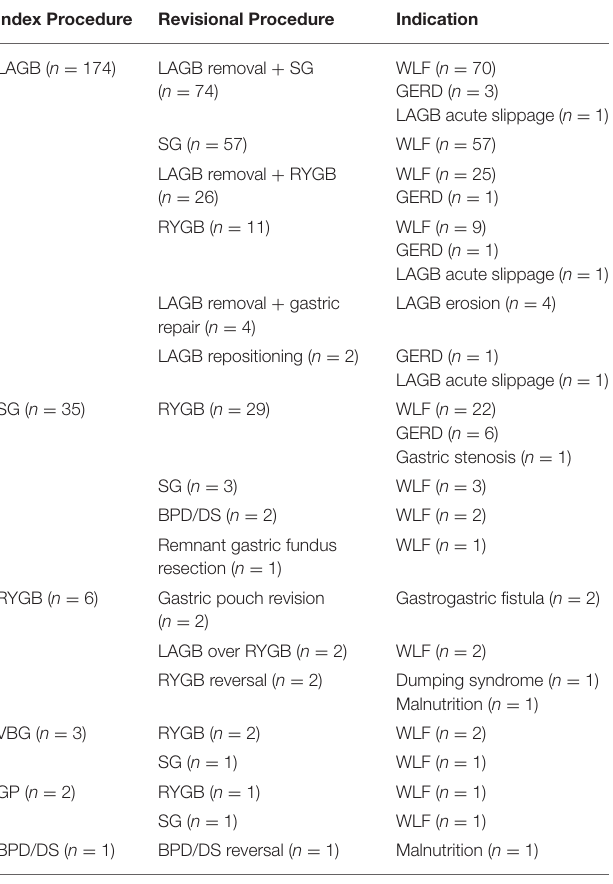
TABLE 2 | Indication for RBS. TABLE 3 | Postoperative